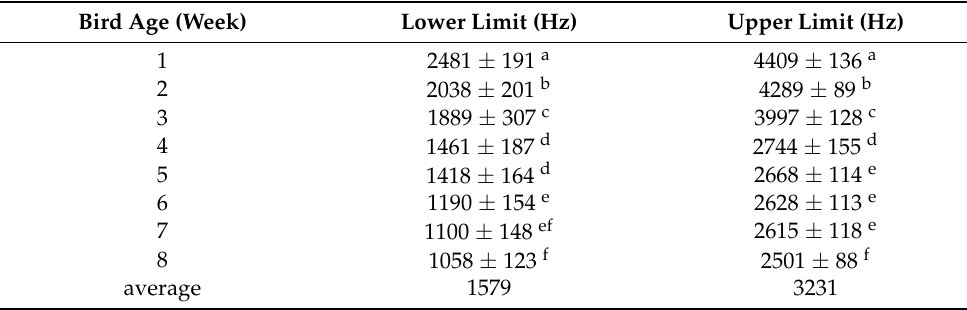
Table 2. Frequency range of bird vocalization at different bird ages (mean ± SD).